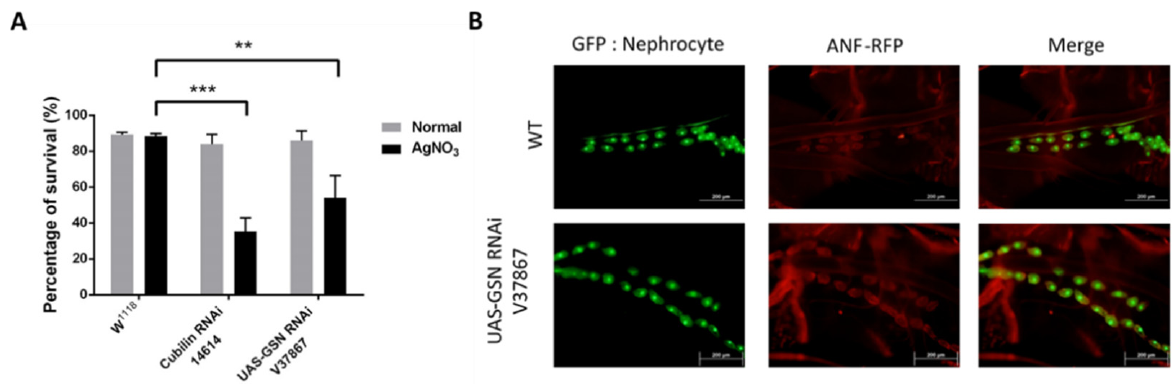
Figure 1. ( A ) Survival of gelsolin-knocked down Drosophila after AgNO 3 exposure. The W1118 strain of Drosophila was used to represent wild-type Drosophila, and Cubilin knockdown flies served as a positive control in this toxin assay. Although gelsolin-knockdown Drosophila did not show altered viability under normal conditions, their rate of survival was dramatically reduced under stress conditions caused by AgNO3 toxin. n = 300, ** p < 0.01, *** p < 0.001. ( B ). Dissection of Drosophila nephrocytes. Nephrocytes from gelsolin-deficient Drosophila accumulate more ANF-RFP. (ANF = Atrial natriuretic factor).